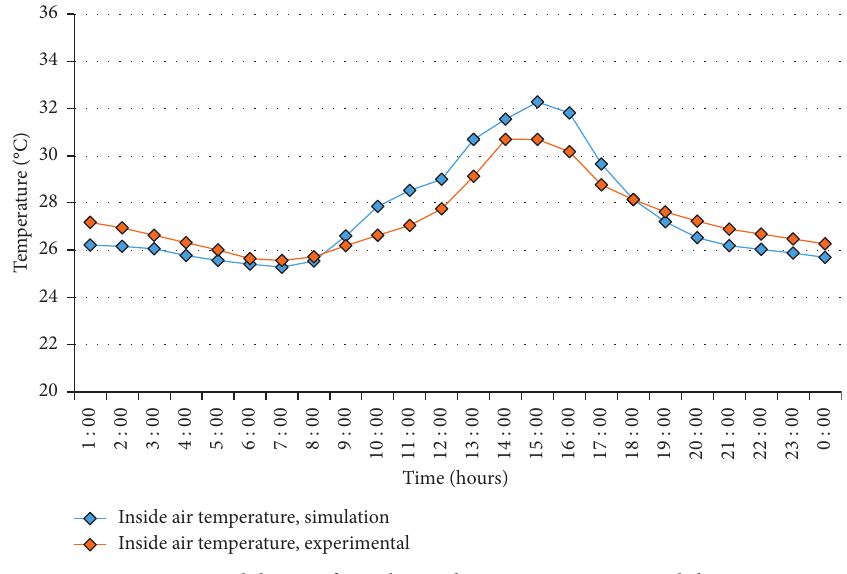
Figure 6: Validation of simulation data against experimental